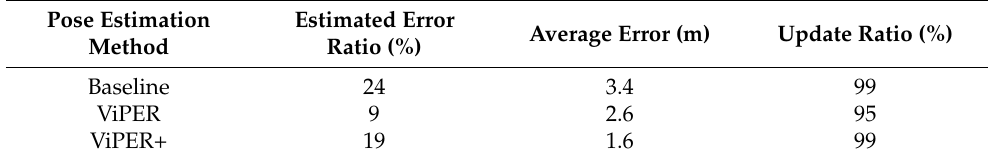
Table 3. Pose estimation result for LOS scenario. ViPER+ provided the same update rate as the baseline method while reducing the error rate and average error compared to the baseline.